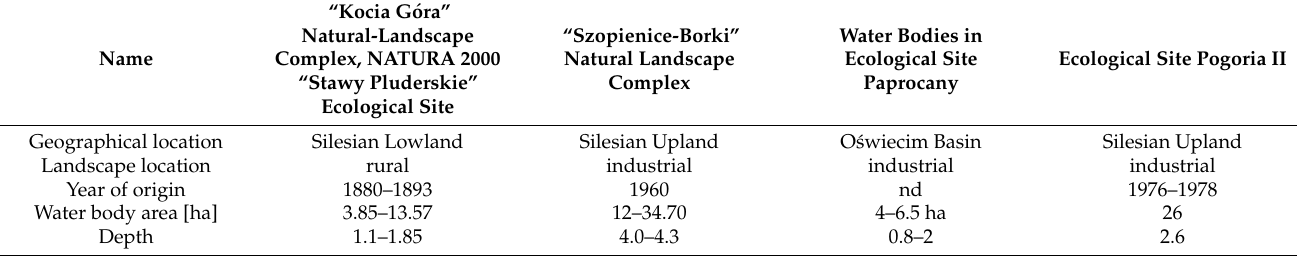
Table 1. Environmental characteristics of the water bodies covered with different forms of habitat protection; Aquatic plant identification was performed by the authors; Data on Avifauna and Ichtio- fauna and hydromorphology of habitats, physico-geographical mesoregions of Poland according to: Spałek et al., 2006 [33], Franczak U., W ó jcicka-Rosi´nska A., 2013 [34], Tokarska-Guzik et al., 2002 [35]; nd—no